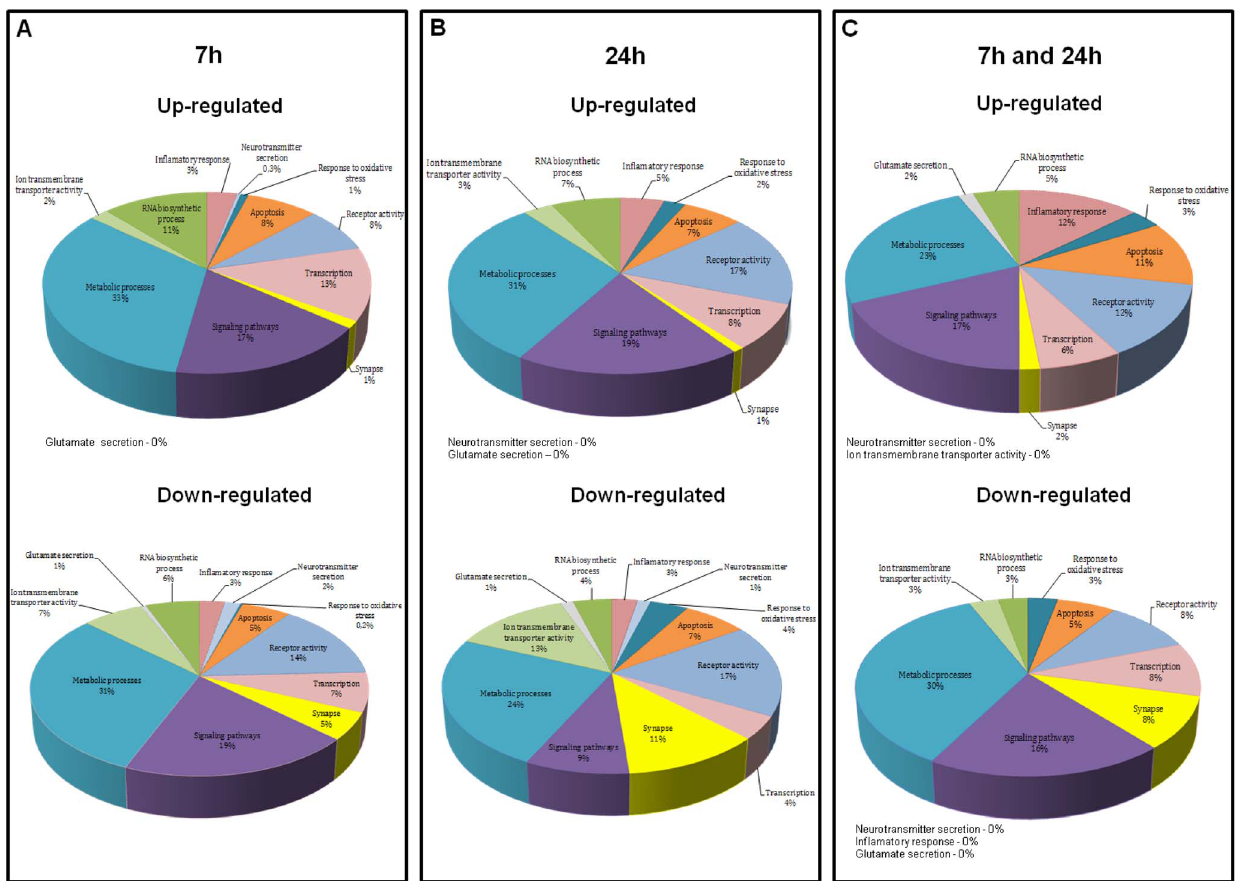
Figure 5. Ontology of genes differentially expressed at 7 h and 24 h of incubation after 2 h of OGD. Gene ontology analyses included genes that had a p -value , 0.05 and a fold change of 2.0 and were performed using GoMiner. Classes were selected manually and the number of genes for each class divided by the sum of the total number of genes in the selected classes (586 genes at 7 h and 403 genes at 24 h). Note that some genes are included in more than one class. ( A ) Ontology of genes up-regulated (upper) and down-regulated (lower) relatively to the control at 7 h of incubation in culture conditioned medium after 2 h OGD. In this analysis, the total numbers of up-regulated and down-regulated genes were 232 and 354, respectively. ( B ) Ontology of genes up-regulated (upper) and down-regulated (lower) relatively to the control at 24 h of incubation in culture conditioned medium after 2 h OGD. In this analysis, the total numbers of up-regulated and down-regulated genes were 333 and 70, respectively. ( C ) Ontology of genes up-regulated (upper) and down-regulated (lower) at 7 h and 24 h of incubation in culture conditioned medium after 2 h OGD. In this analysis, the total numbers of up-regulated and down-regulated genes were 60 and 31, respectively.